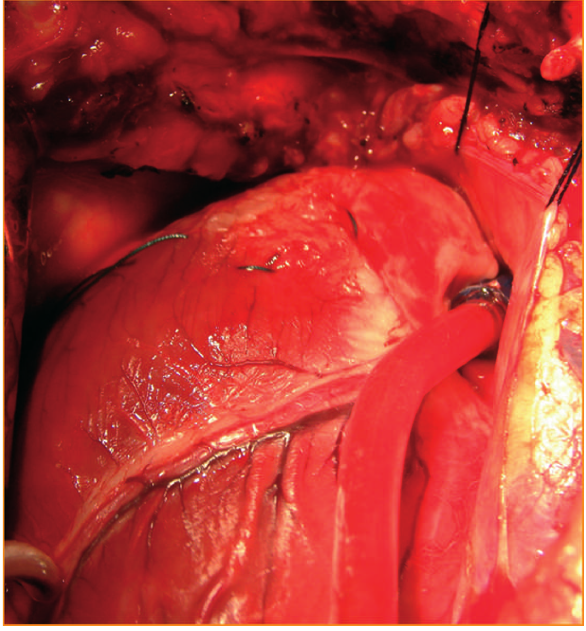
Fig. 2. Face anterior do ventrículo direito. Seta: sutura em